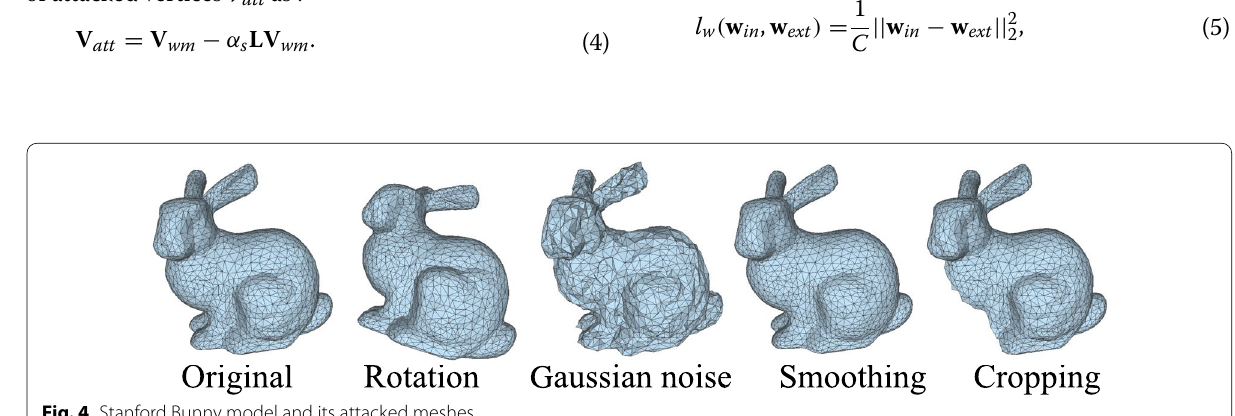
Fig. 4 Stanford Bunny model and its attacked